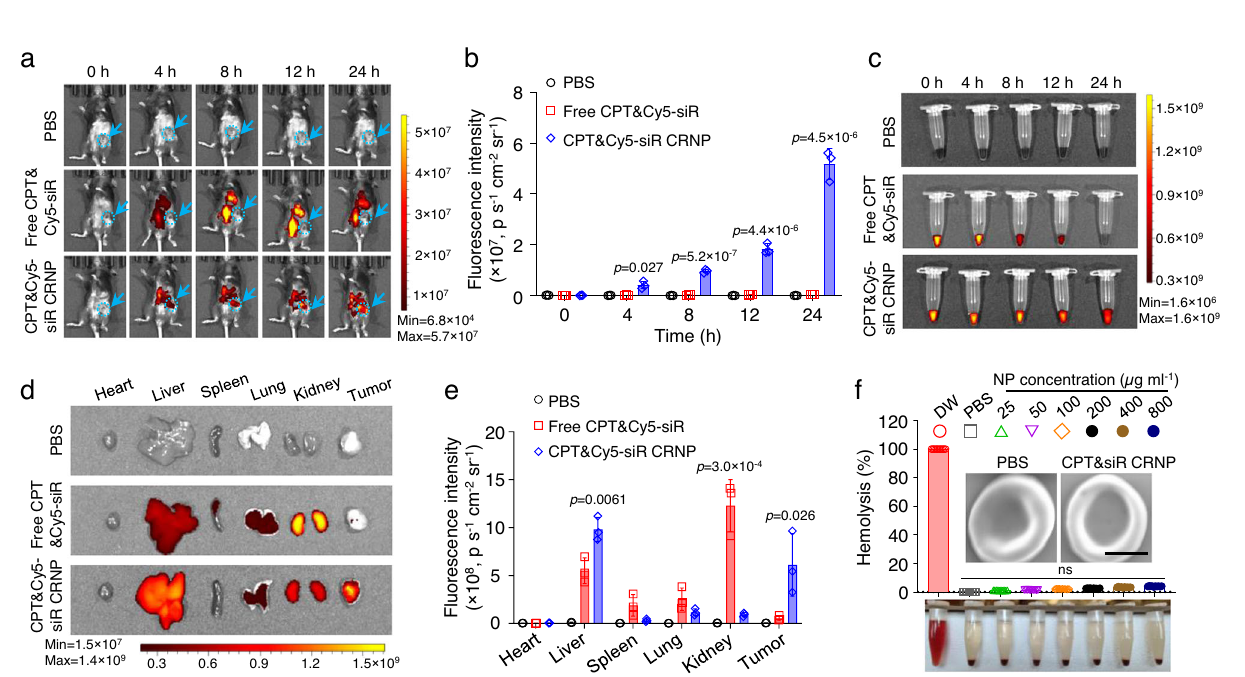
Fig.4|CRNPsshowhighaccumulationinorthotopicbreasttumorsinvivoand excellent blood compatibility. a, b Whole animal images ( a ) showing the in vivo distribution of CPT&Cy5-siR CRNPsand the corresponding quantitative data ( b ) of the fl uorescence intensity of CPT&Cy5-siR CRNPs in E0771 tumors from IVIS ima- ging at different time points after intravenous injection of the CRNPs ( n =3 mice). PBS and free CPT&Cy5-siR were investigated for comparison. The blue arrows and dashed circles indicate the locations of tumors. c Representative images acquired by IVIS imaging showing the Cy5 fl uorescence intensity in blood drawn at various timepointsfrommiceafterinjectionwithPBS,freeCPT&Cy5-siR,andCPT&Cy5-siR CRNPs(atthesameCy5-siRdoseasfreeCPT&Cy5-siR)( n =3mice). d , e TypicalIVIS images ( d ) and the corresponding quantitative data ( e ) showing the Cy5 fl uores- cenceindifferentorgansincludingtumorscollectedfrommiceinjectedviatailvein